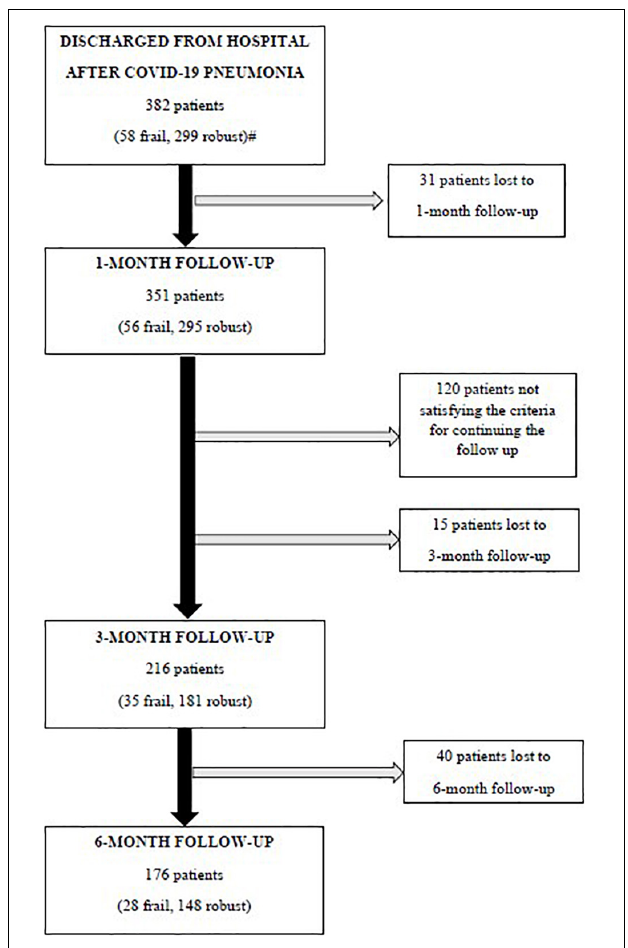
FIGURE 1 | Flowchart of the follow-up visits. Criteria for continuing the follow-up: (i) a respiratory rate > 17 breaths/min plus, either a history of coronary heart disease, or the general Visual Analog Scale (VAS) score < 86 or a C-reactive protein at hospital admission > 149 mg/l or (ii) patients aged 63 years or older with a respiratory rate < 17 breaths/min, but a body mass index (BMI) ≥ 26 kg/m 2 , continued the follow-ups at 3 and 6 months. #Missing data for calculating the baseline frailty index in 25